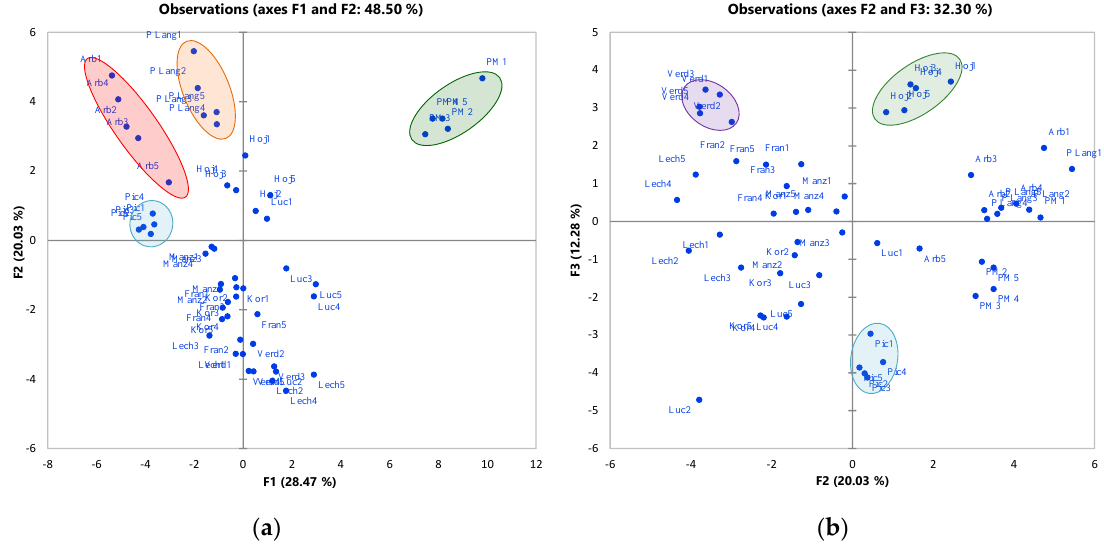
Figure 3. Scatter plot of the PCA scores projected on PC1, PC2 ( a ) and PC2, PC3 ( b ). Abbreviations meaning as in Figure 2. (Even though the statistical treatment was carried out considering the independent extracts and injections of each sample, just the mean value was represented here to facilitate the visual inspection of the figure).